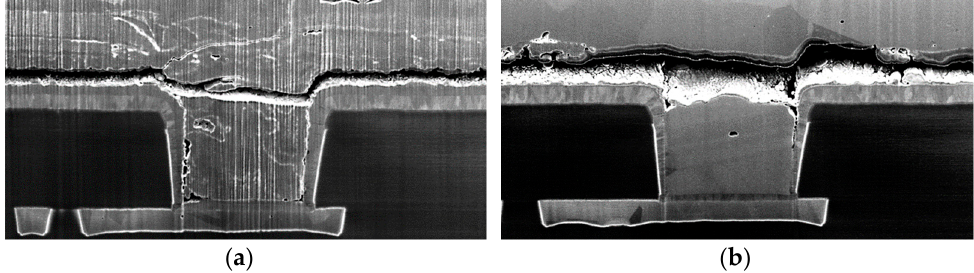
Figure 19. Close-up of the cross-sections of the stressed samples in the vicinity of the delamination